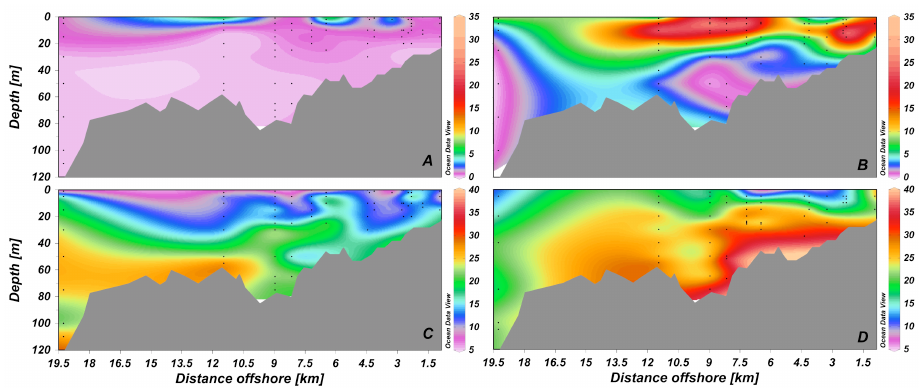
Fig. 3. Cross sections of nitrate (µM, panels A, B ), chlorophyll- a (mgm − 3 , panels C, D ) during austral winter (left) and spring-summer (right) panels in the Itata river and the adjacent coastal area. X-axis is the distance from the coast. Map generated using the software Ocean Data View (Schlitzer, 2010).